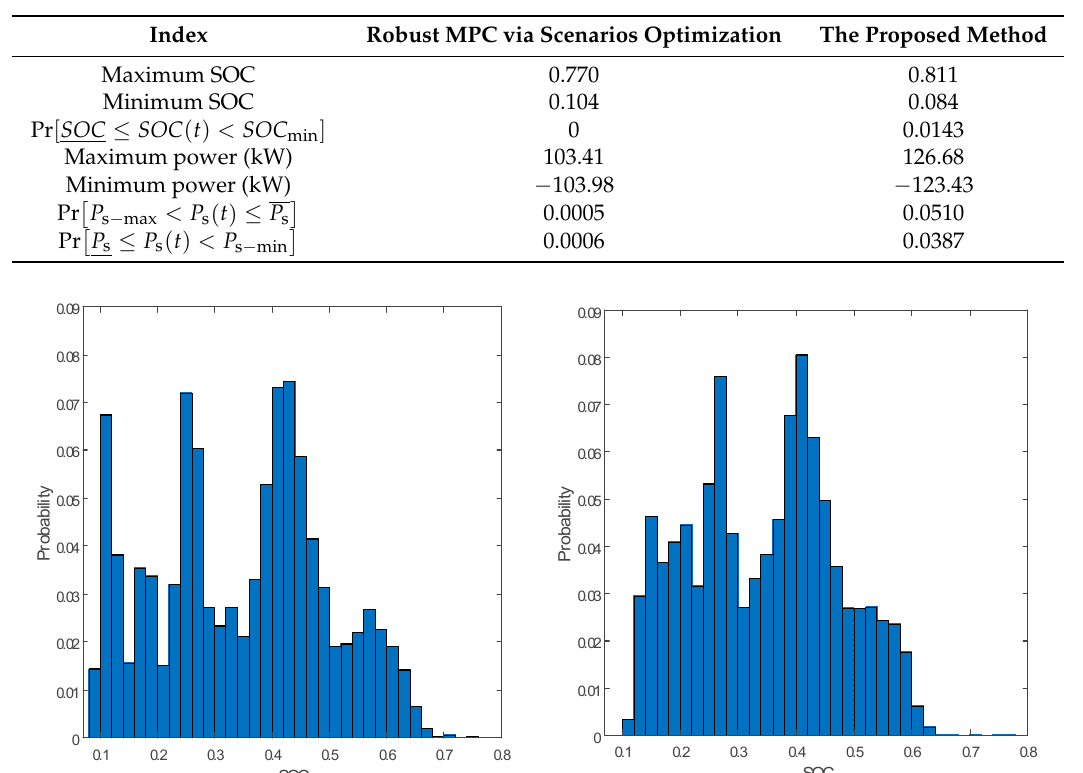
Table 2. Comparison on energy storage utilization between the proposed Method and Robust MPC via Scenarios Optimization.